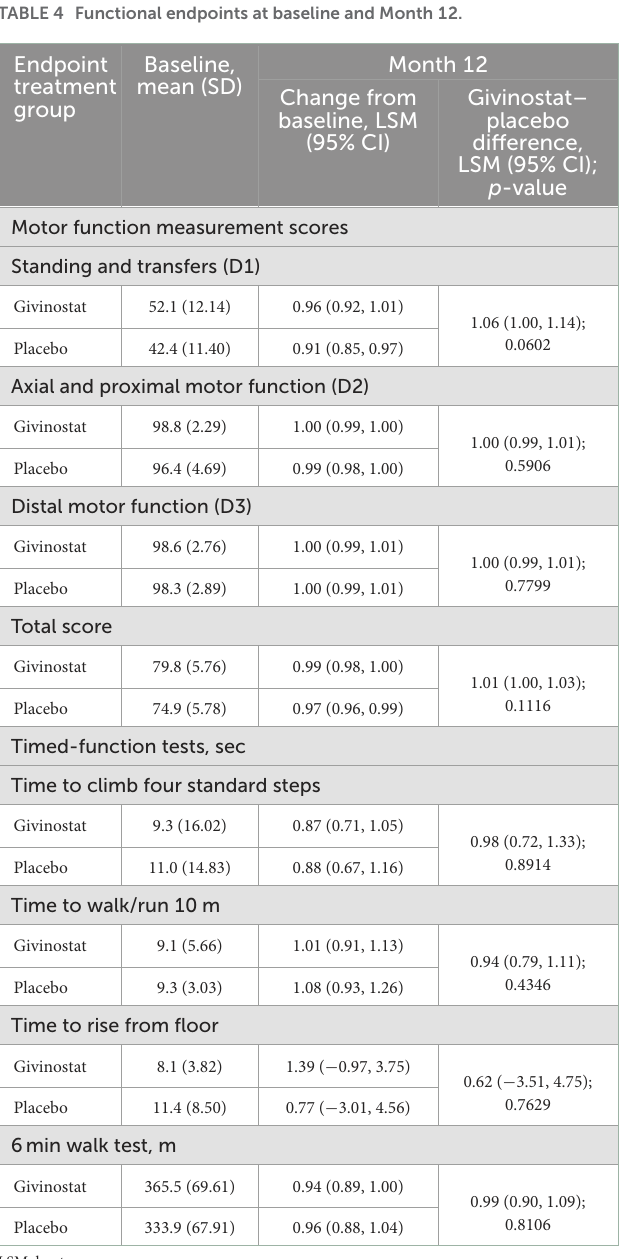
TABLE 3 MRI and MRS fat fractions at baseline and Month 12. TABLE 4 Functional endpoints at baseline and Month